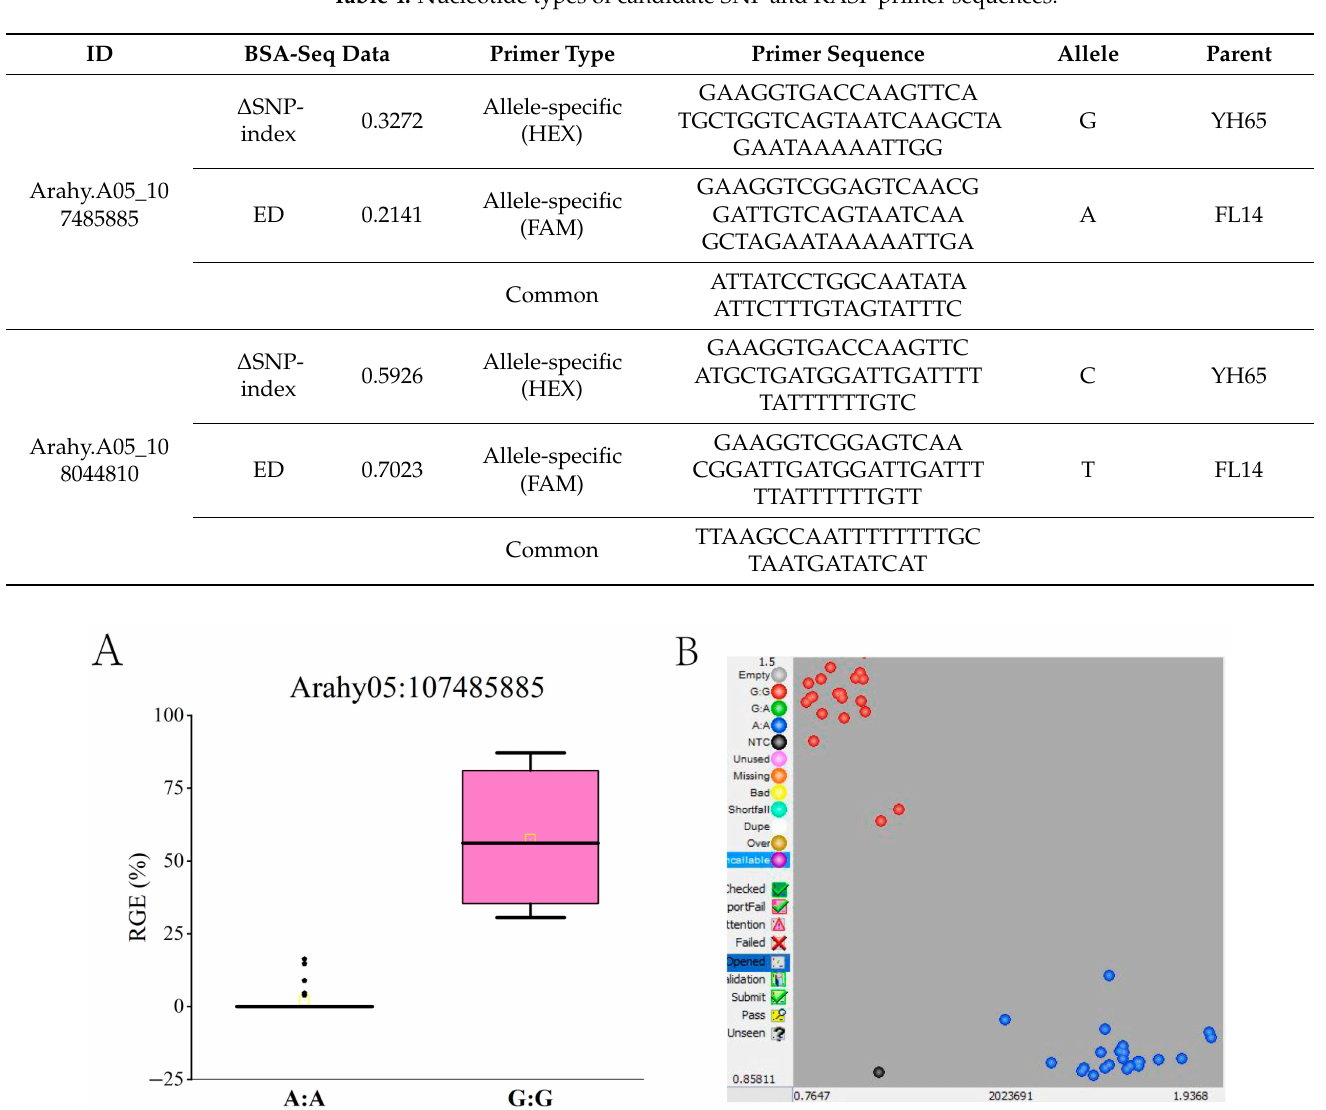
Table 4. Nucleotide types of candidate SNP and KASP primer sequences.